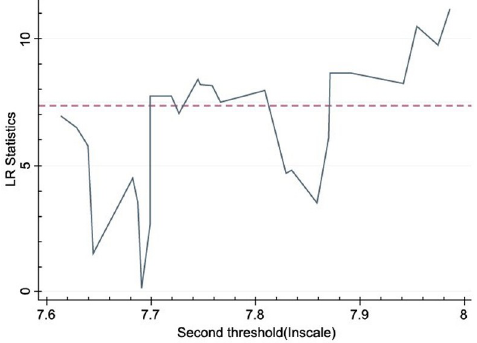
Fig 2. Estimation and likelihood ratio function of apple’s second production